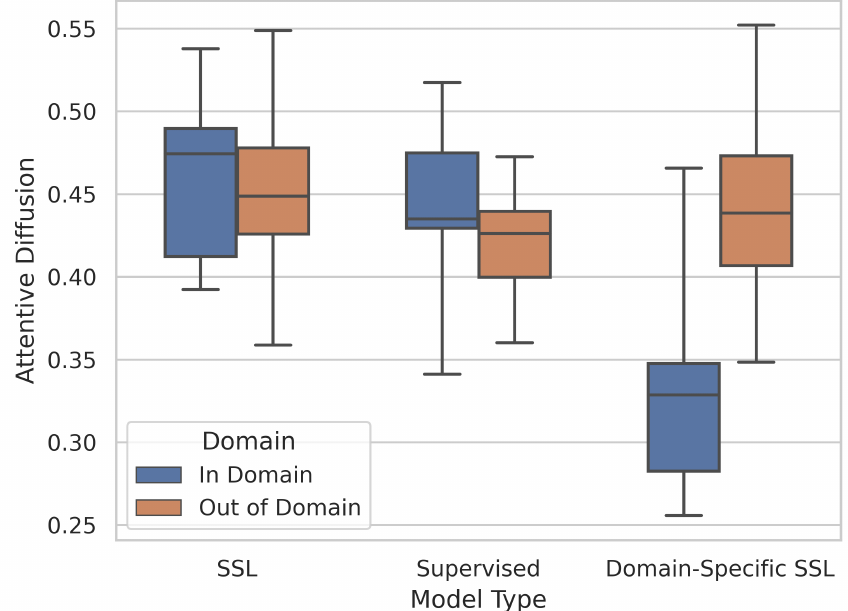
Figure 9. Box-and-whisker plot of model type (SSL, Supervised, and Domain-Specific SSL (MIMIC- CheXpert and MoCo-CXR)) against attentive diffusion values, split between in-domain (CheXpert, ChestX, Montgomery, Shenzhen) and out-of-domain (BACH, EyePACS, iChallenge-AMD, iChallenge- PM)